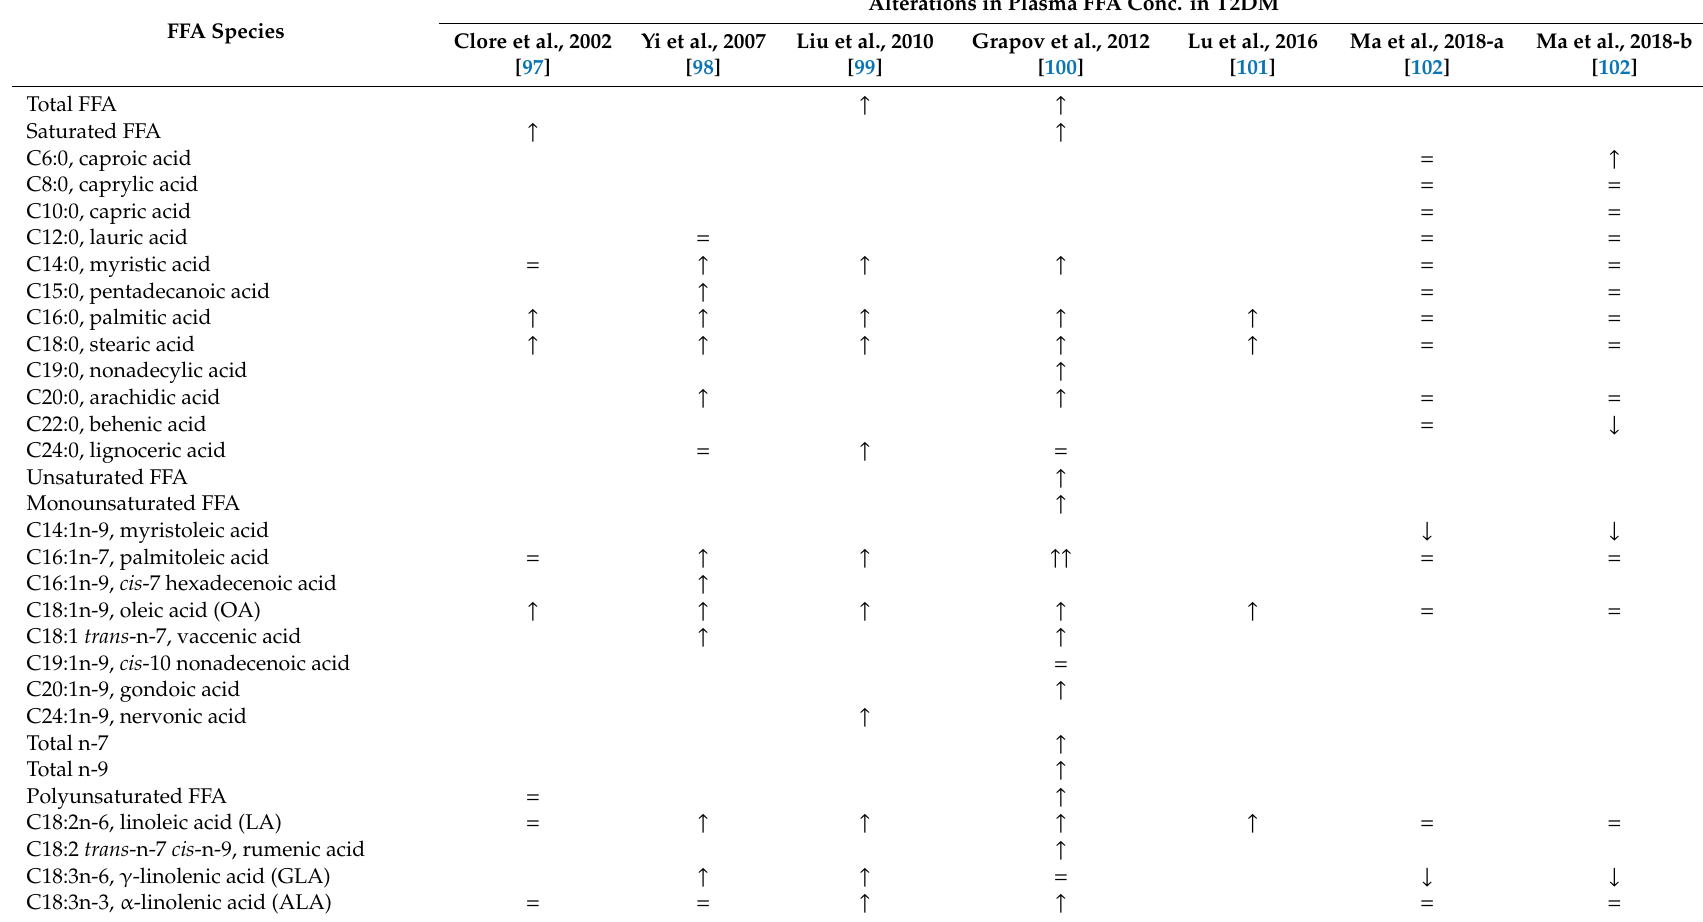
Table 2. Changes in FFA concentrations measured in blood from subjects with T2DM compared to controls. Elevated FFA concentrations are indicated with ↑ , reduced concentrations with ↓ , unchanged concentrations with =